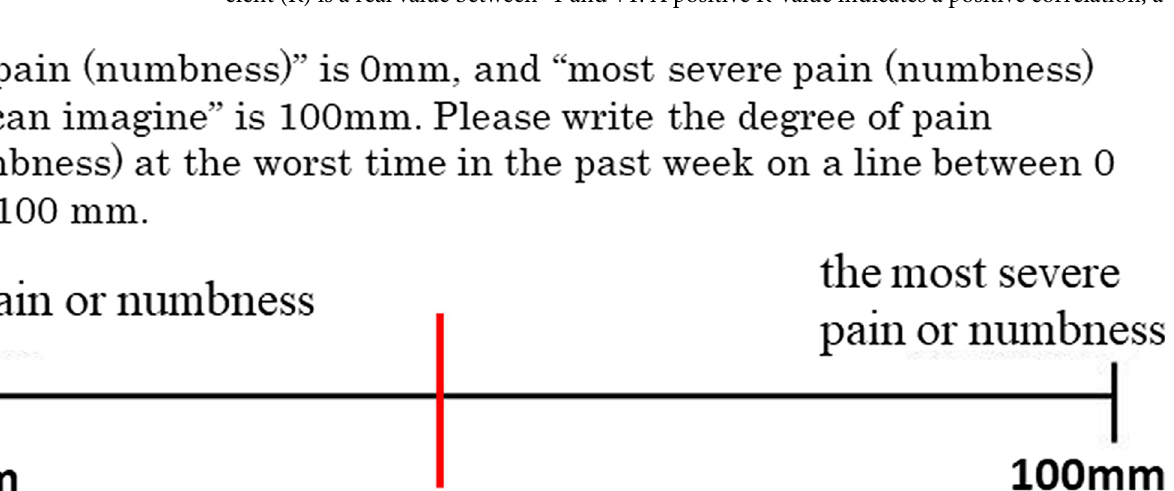
PLOS ONE | https://doi.org/10.1371/journal.pone.0243861 December14,